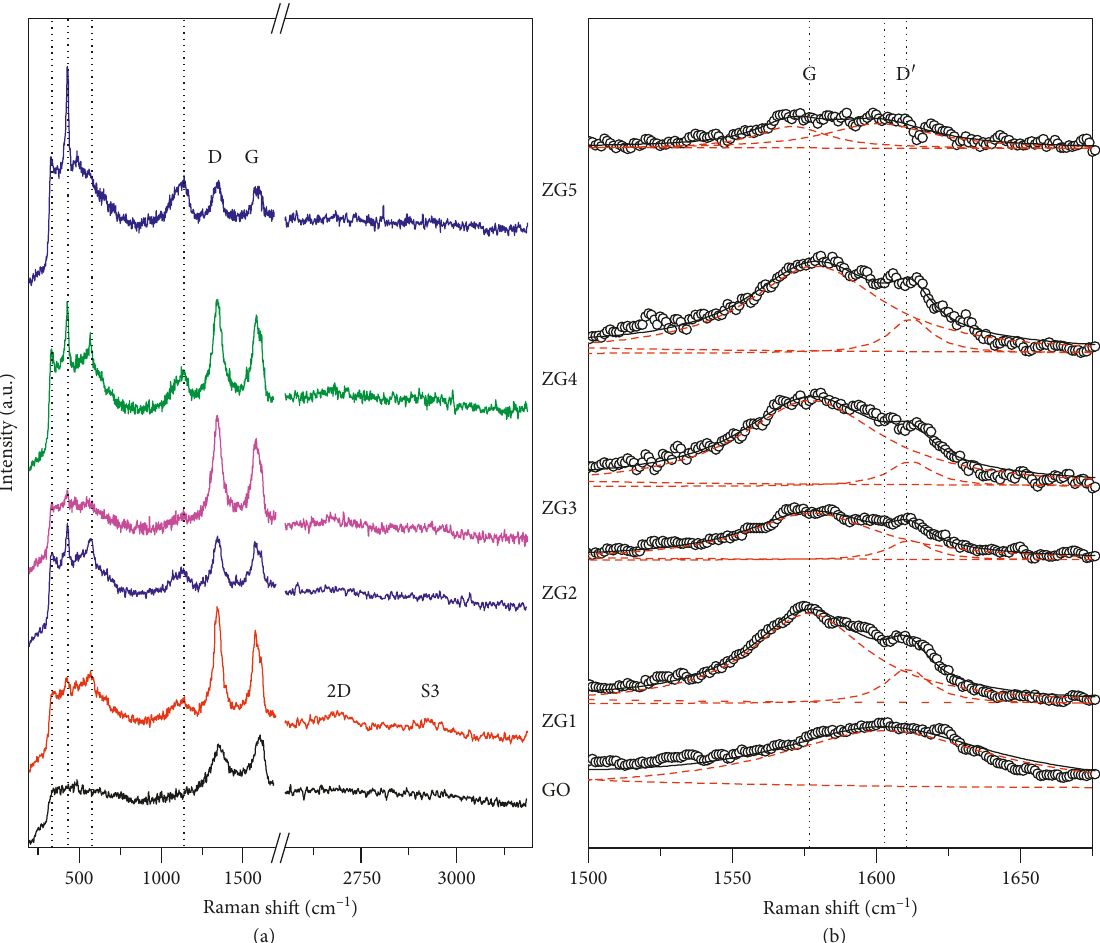
Figure 3: Raman spectroscopy measurements of samples GO, ZG1, ZG2, ZG3, ZG4, and ZG5 for (a) the full range from 200 cm − 1 to 3300 cm − 1 and (b) the range corresponding to the